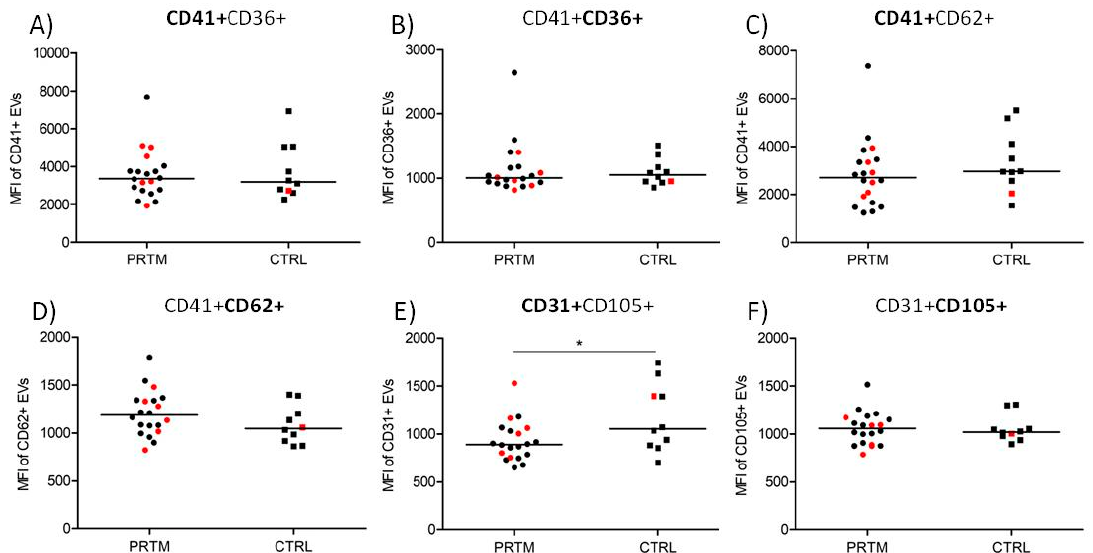
Figure 5. Comparison of median fluorescence intensity of labeled large EVs in cord blood plasma of PRTM and CTRL. Platelet (CD41+CD36+), activated platelet (CD41+CD62+), and endothelial (CD31+CD105+) EVs in preterm newborns (PRTM; circles, n = 20) and control newborns (CTRL; squares, n = 10) were analyzed. MFI of EVs labeled with CD41 PE ( A ), CD36 FITC ( B ), CD41 FITC ( C ), CD62 PE ( D ), CD31 FITC ( E ), and CD105 PE ( F ) are presented. Red symbols represent hemolytic samples (Hb > 0.1 mg/mL). The medians are shown. * p < 0.05.